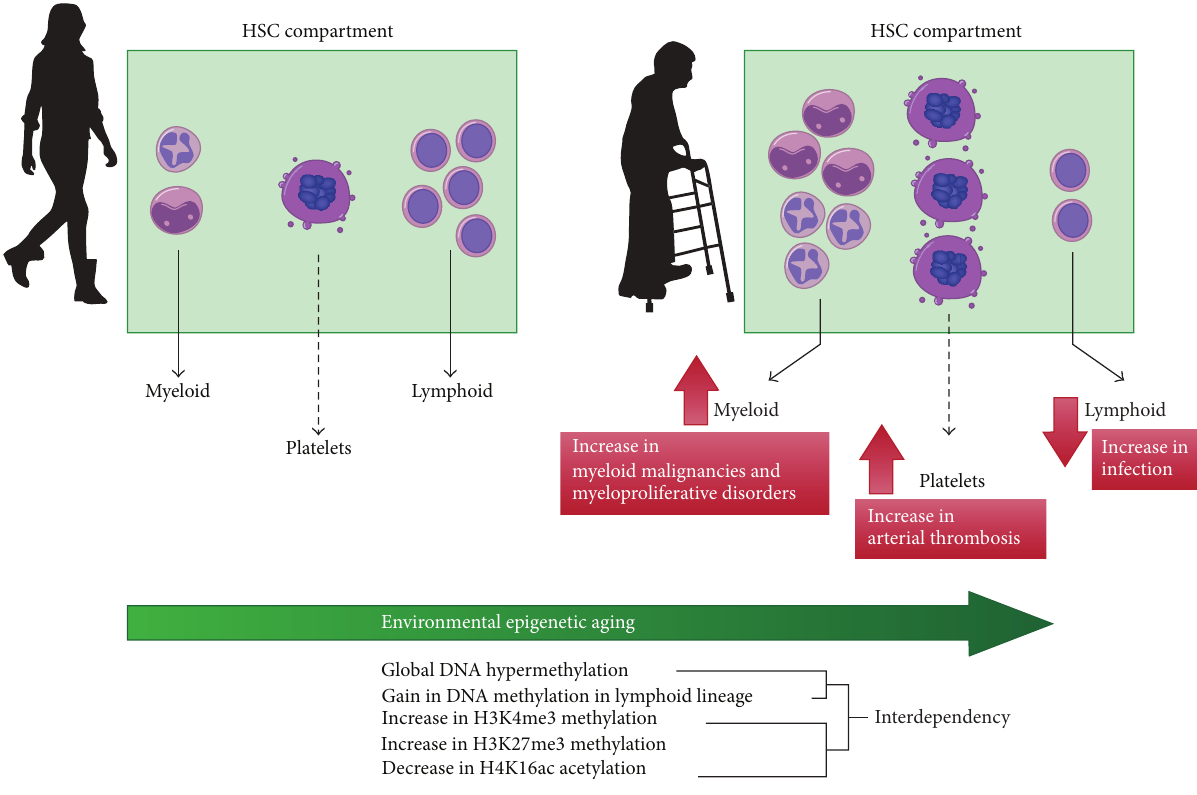
Figure 1: Drift in the epigenetic landscape that occurs with environmental and biological factors associated with aging leads to transcriptional differences between the HSC compartments in the young population compared with the elderly population. This is proposed to give rise to expansion of particular clones within the heterogeneous HSC pool to produce a myeloid- and platelet-skewed haematopoietic system. These changes may play an important role in driving the increased incidence of myeloproliferative disorders, myeloid malignancies, infection, and acute arterial thrombosis observed in the